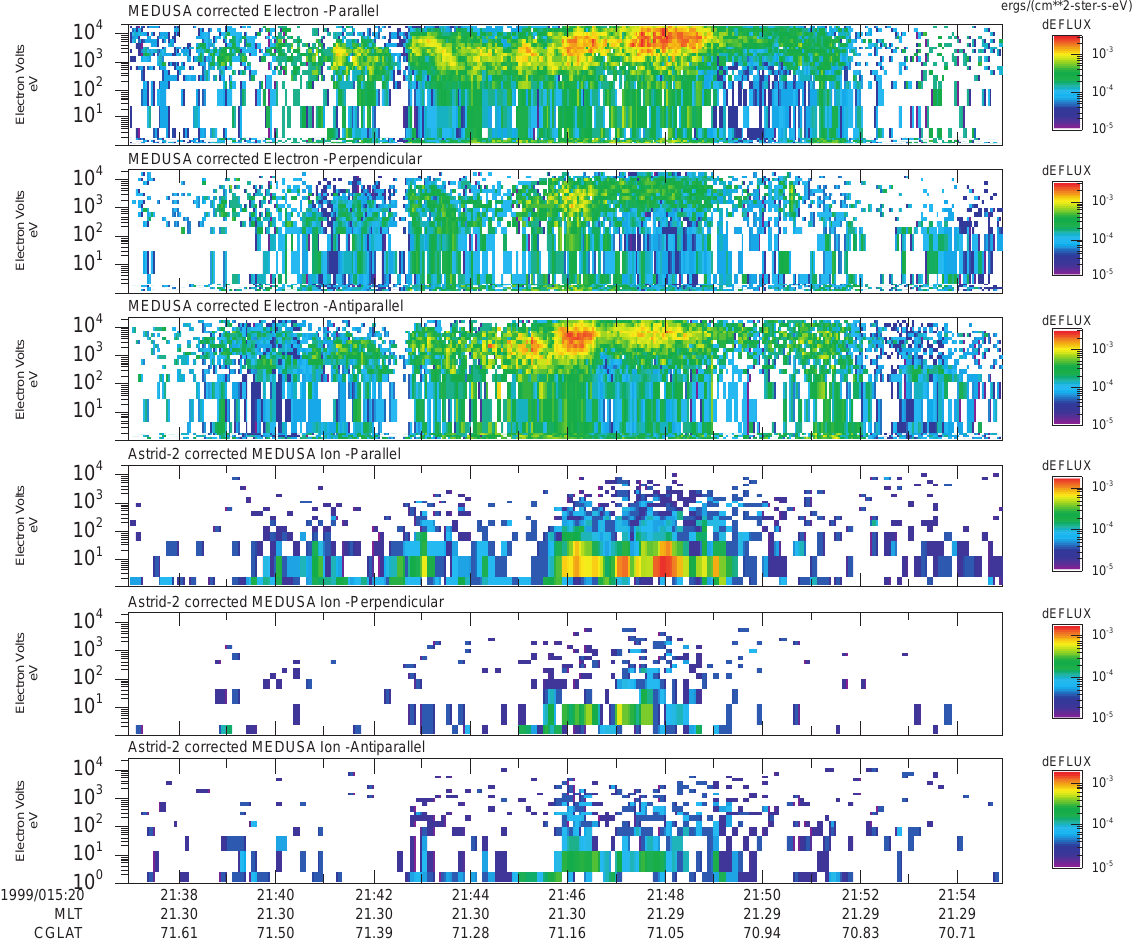
Fig. 3. MEDUSA time-energy spectrogram. During this event the instrument was operated in the “select mode” in which only the most parallel, perpendicular, and most antiparallel sectors for electrons and ions are included. The data has been corrected for variations in sector efficiency, and the color scales represent differential energy flux. This interesting event shows a beam of upward accelerated electrons (third panel from the top), at 20:21:46 UT on 15 January 1999. The electron beam has been accelerated to an average energy of 5